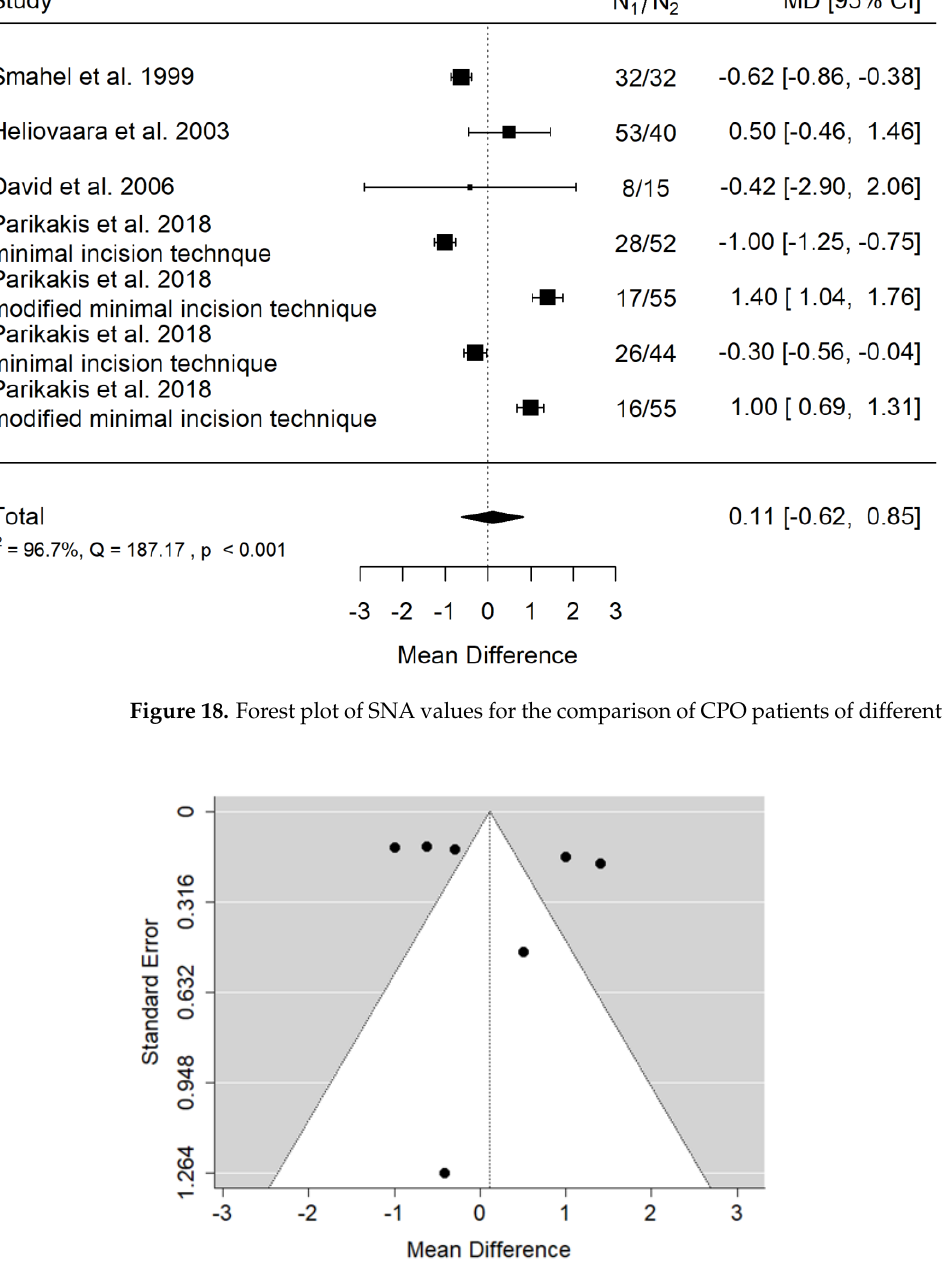
Figure 19. Funnel plot of ANB values for the comparison of CPO patients of different age [20,23,30,32].